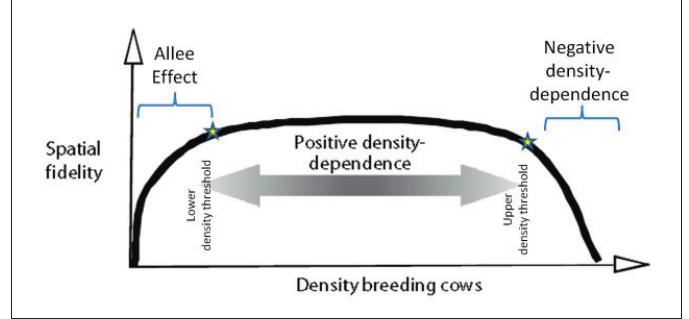
Fig. 1. Proposed curvilinear relationship between spatial fidelity and density of caribou on the calving